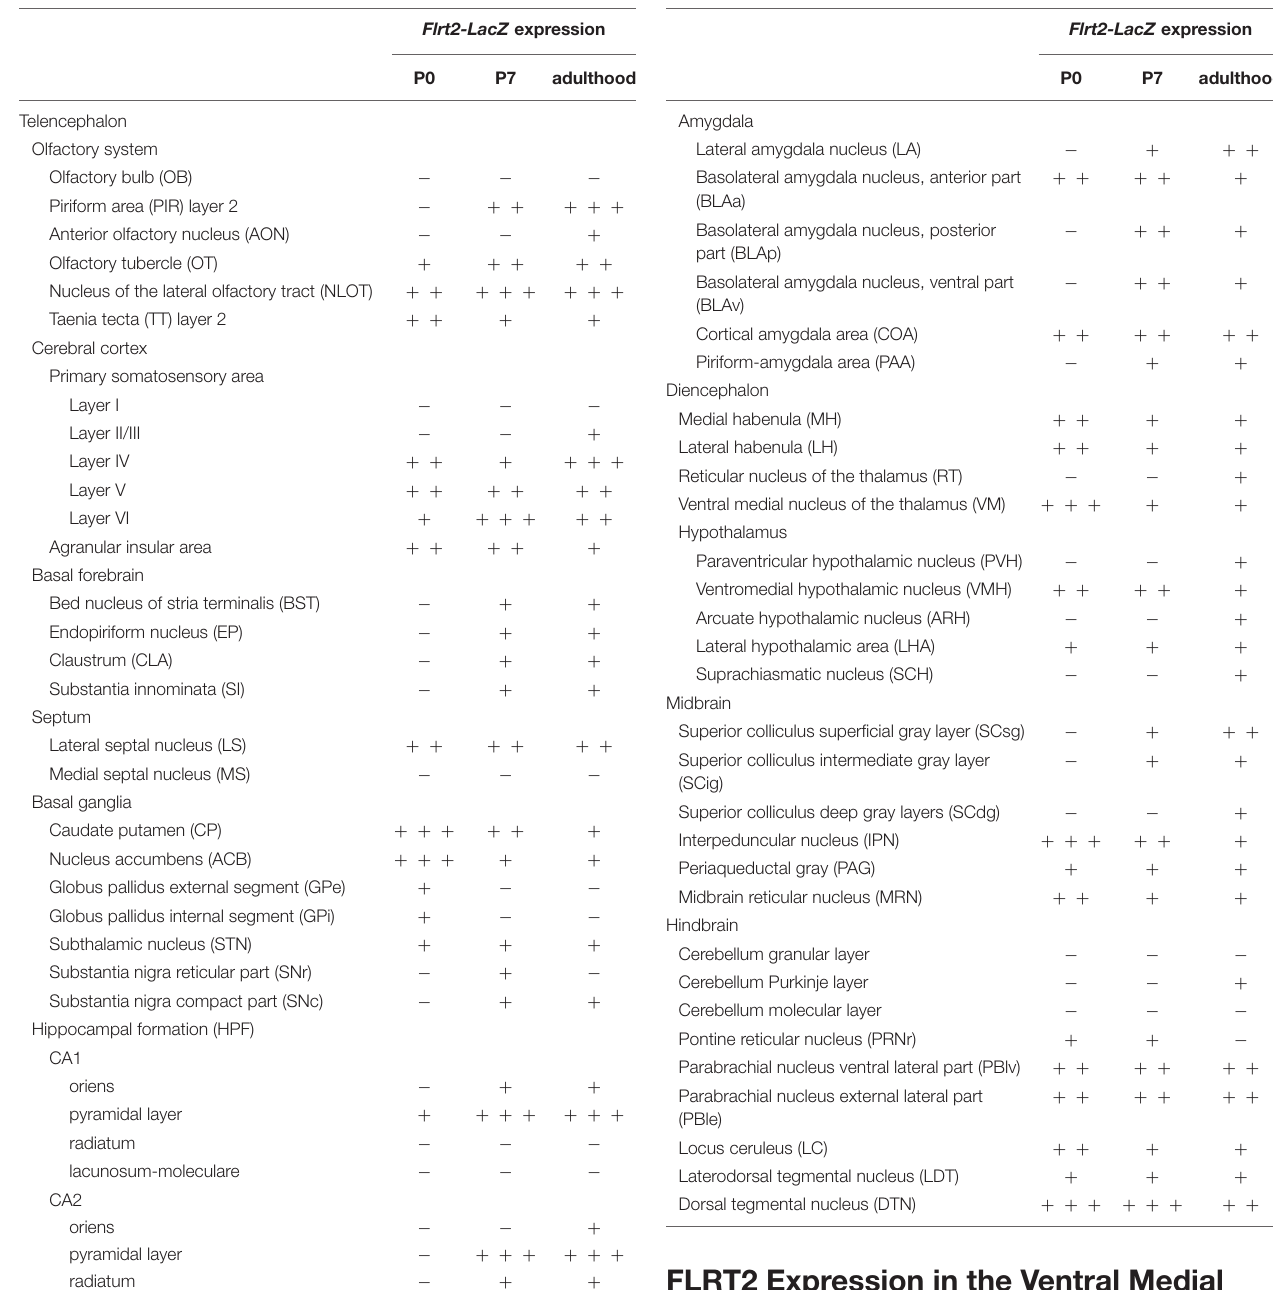
TABLE 1 | Distribution and intensity of FLRT2-LacZ expression in the mouse